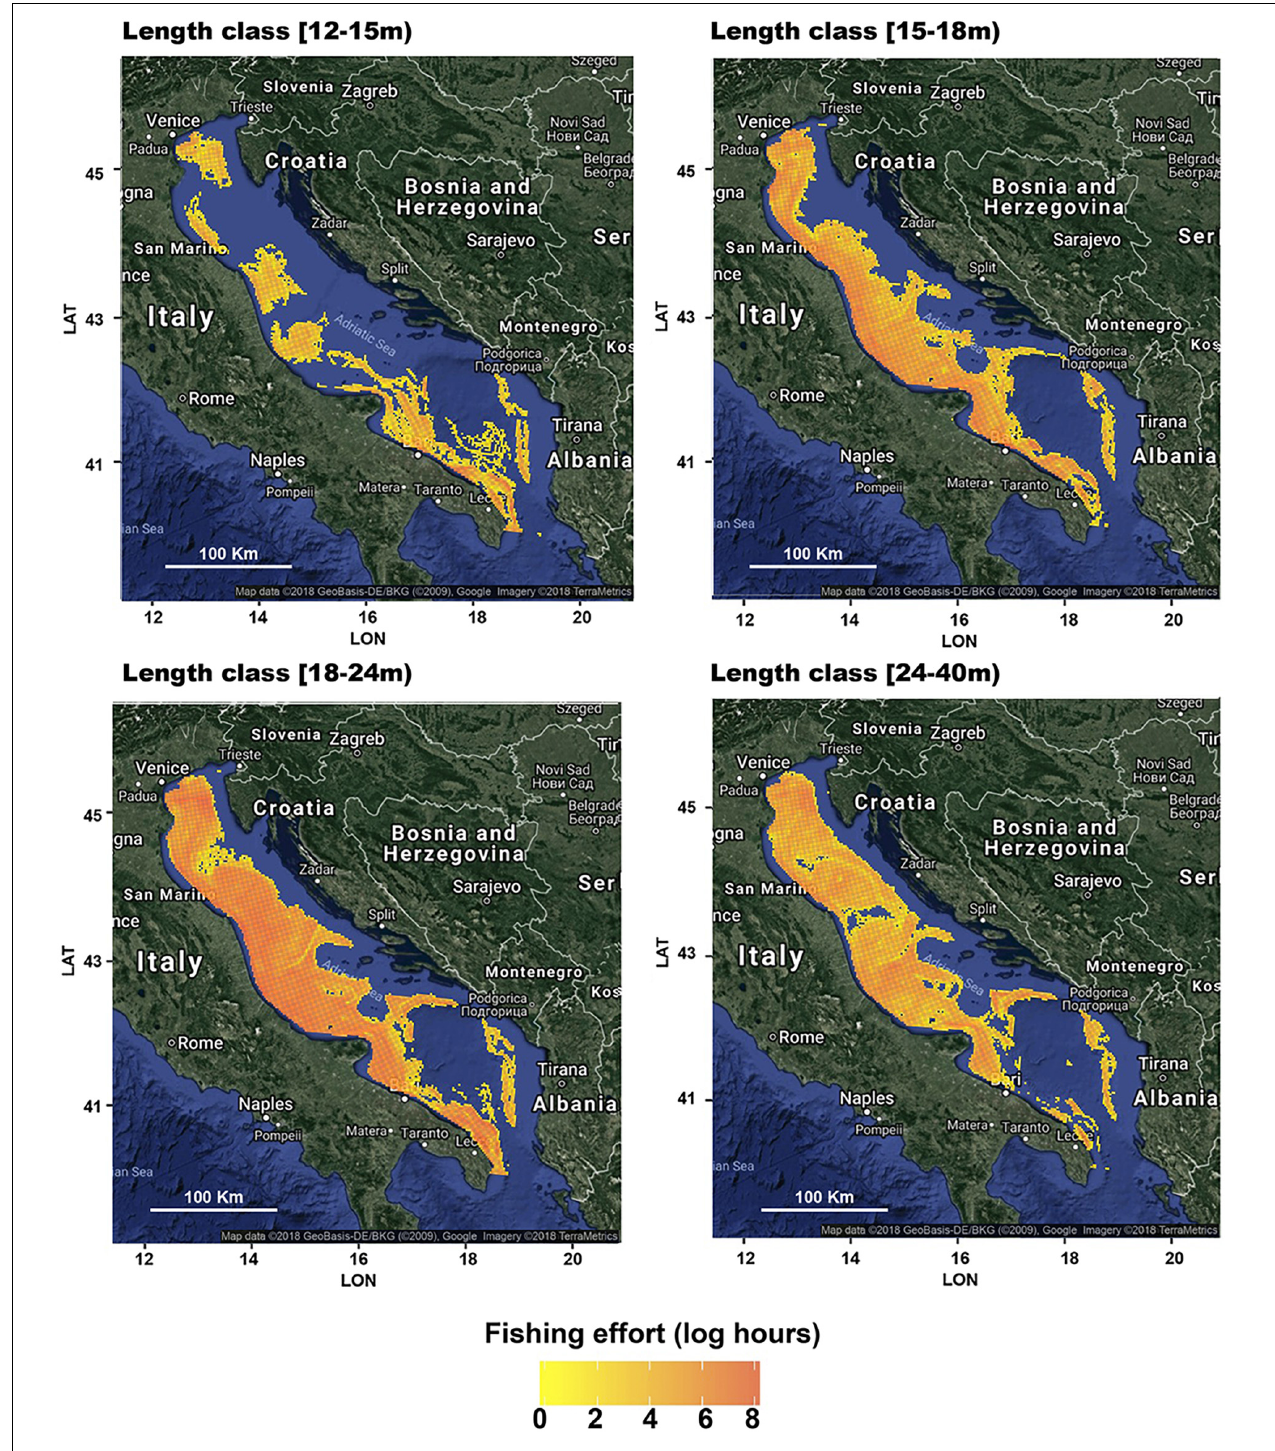
FIGURE 3 | Fishing footprints as the total yearly fishing effort (the means of the years from 2012 to 2016), estimated using the VMS data, for the four length classes that group the Italian trawlers operating in the Adriatic Sea. The effort in the logs of fishing hours was computed with respect to the 3 × 3 km square grid used within the EU DCF for the computation of the ecological indicators of fishing pressure. The effort scale is the same for the four subfigures to provide comparability. The figures were created using the R package ggmap (Kahle and Wickham, 2013) importing images from Google maps.